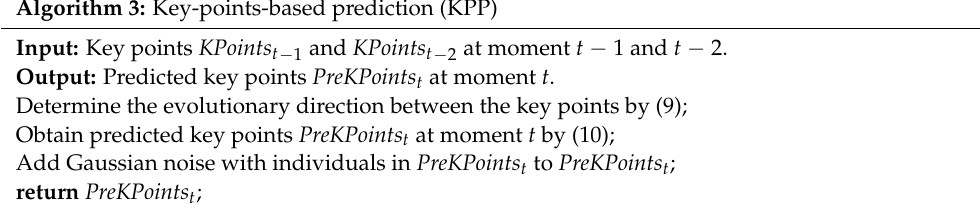
Algorithm 3: Key-points-based prediction (KPP)